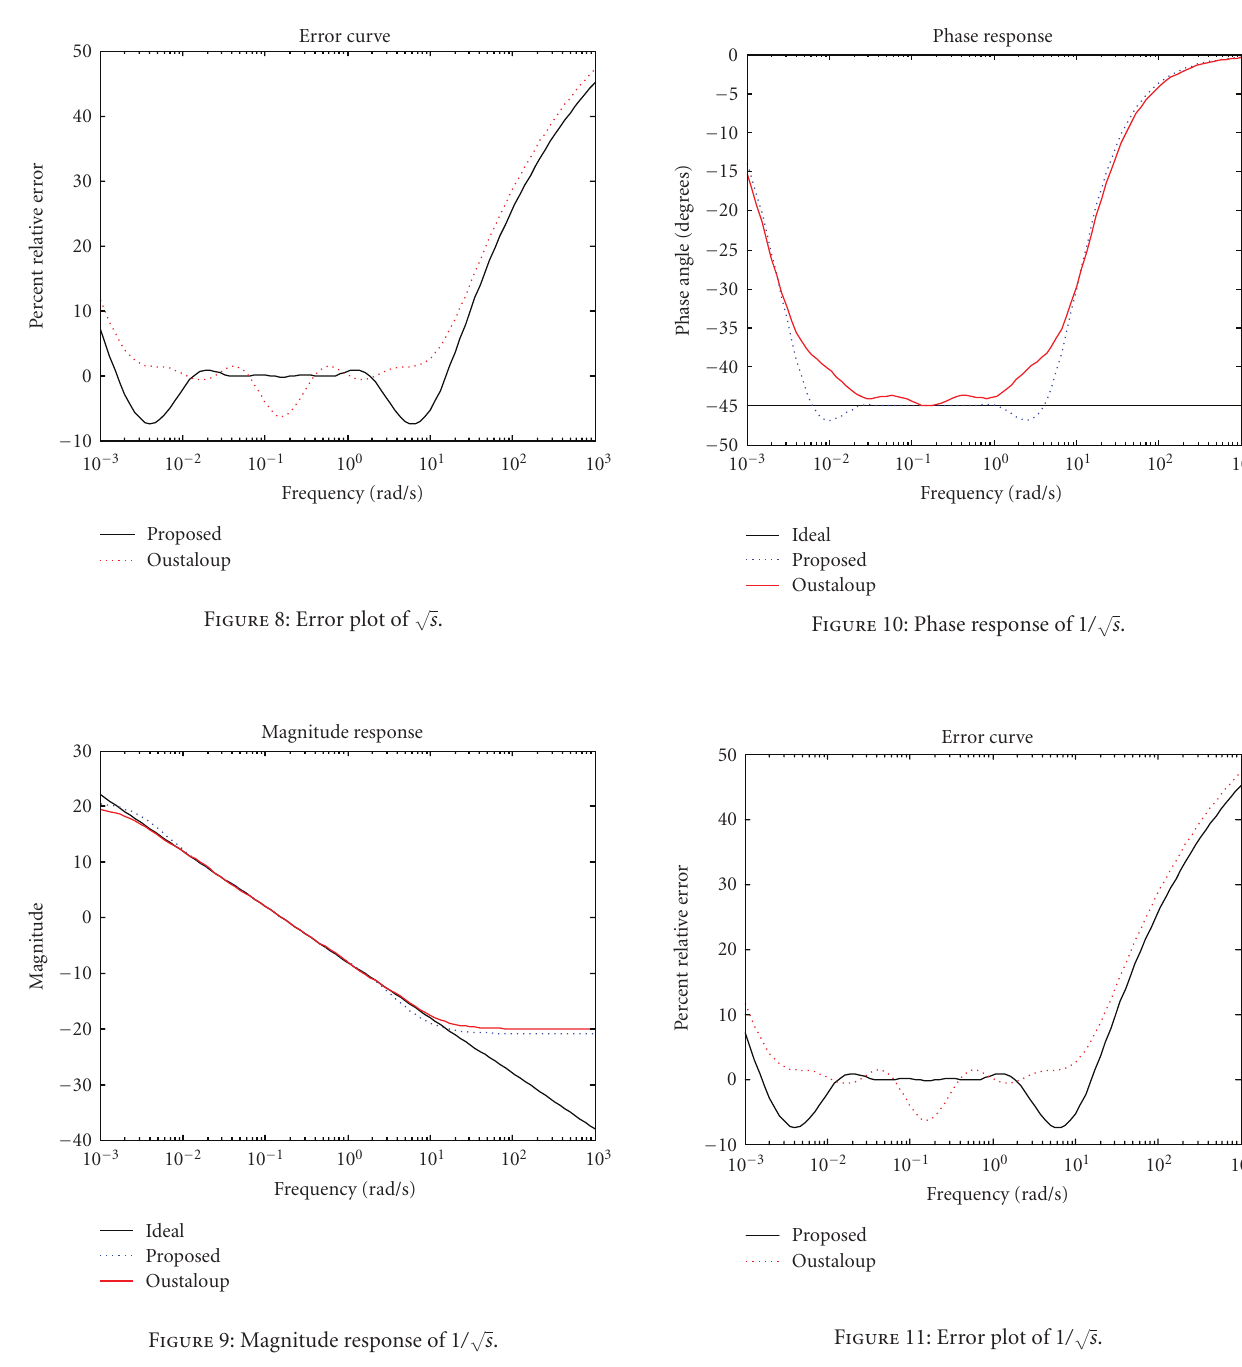
Figure 9: Magnitude response of 1 /